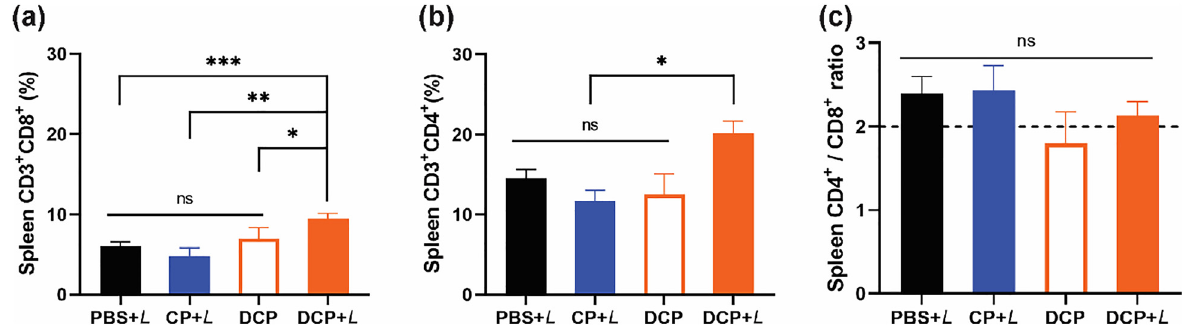
Figure 5: Peripheral adaptive immune response profile. (a) And (b) spleen lymphocyte population and (c) the ratio of CD4 and CD8 T cells of groups G1-G5 at day